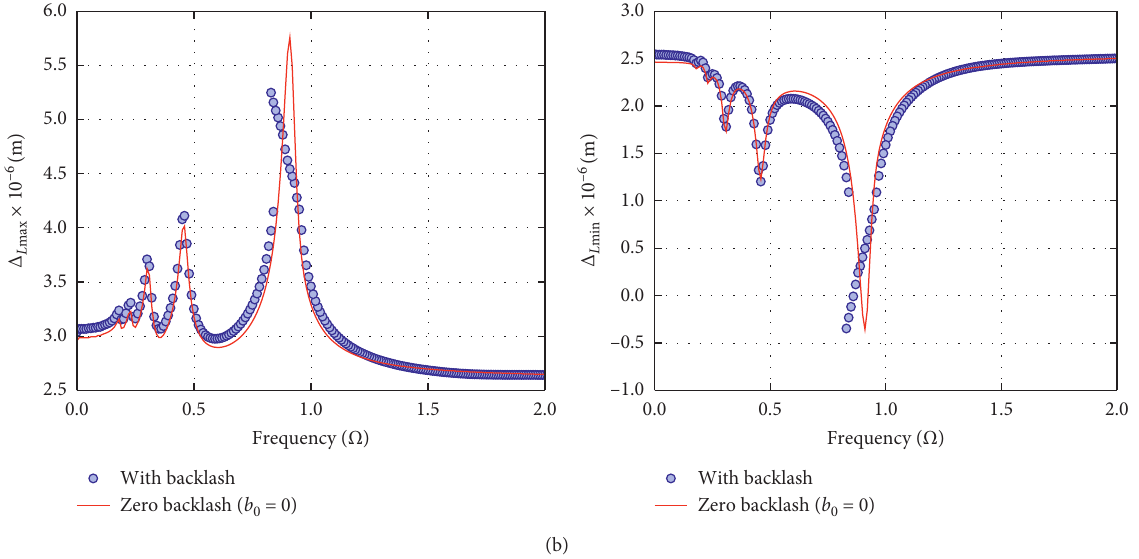
Figure 7: Influence of backlash on vibration response of the gear system. (a) Constant backlash models and (b) dynamic backlash